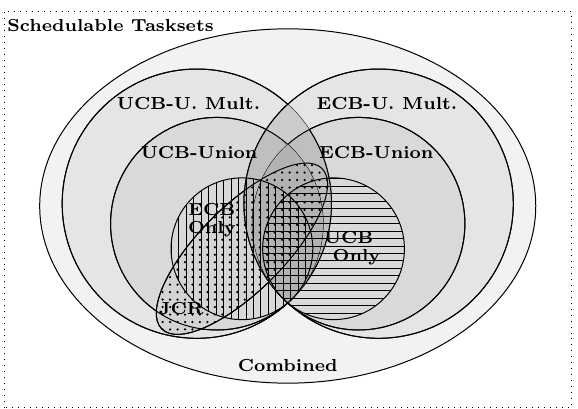
Figure 4 Venn diagram showing the relationship between different approaches for CPRD analysis under EDF